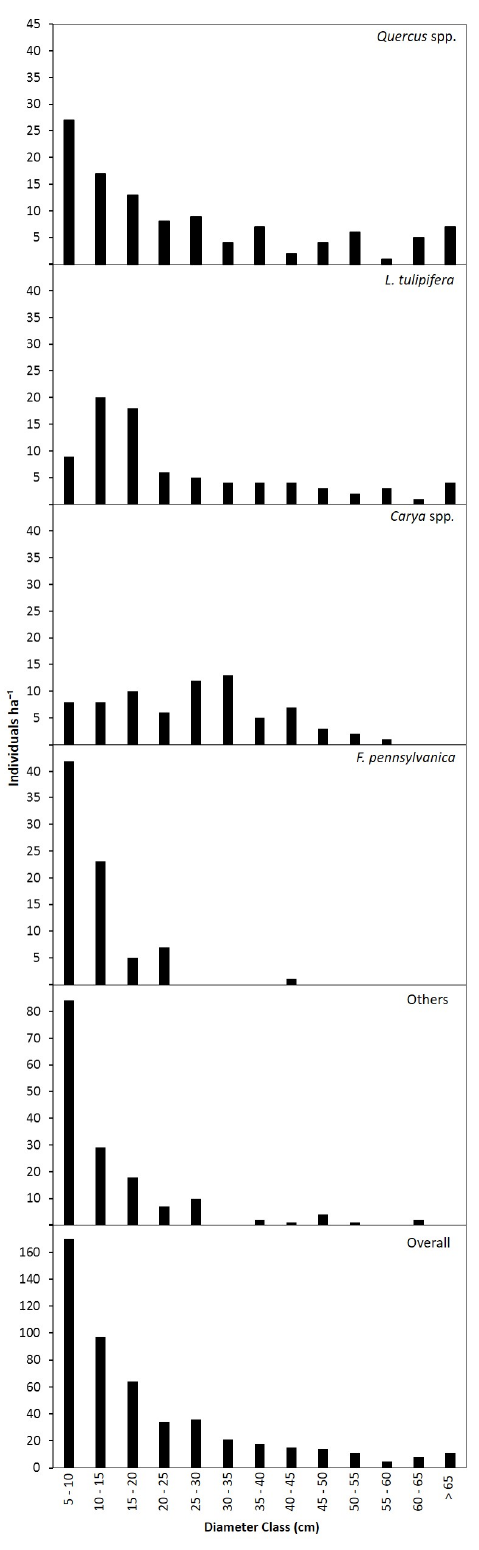
Figure 3. Diameter class distributions of trees ( ≥ 5 cm dbh) by group in a multi-cohort forest on the Oakmulgee Ranger District of the Talladega National Forest, Alabama. See Table 1 for a list of species included in the others group.